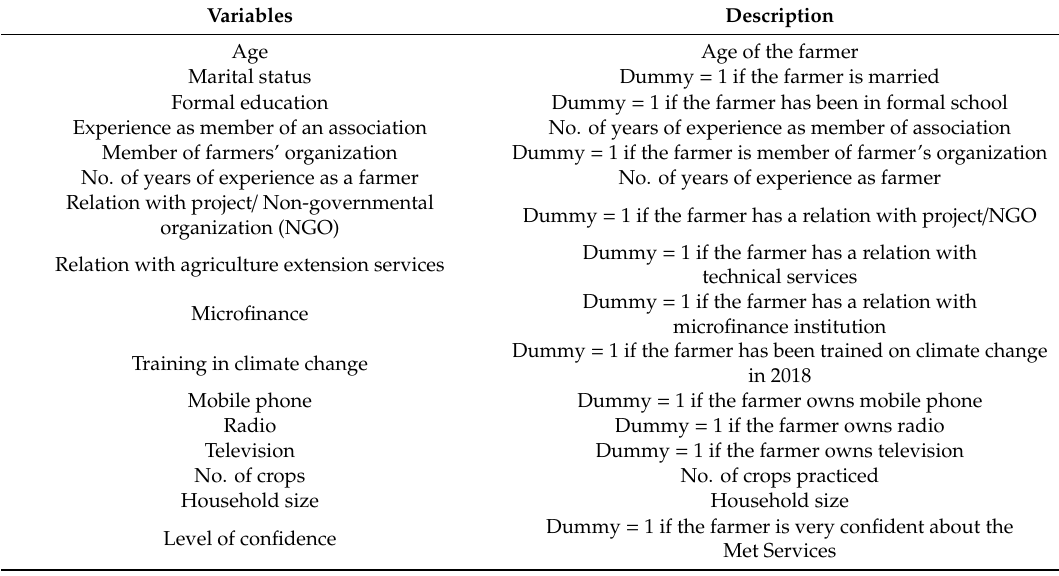
Table 1. Description of the variables introduced in the